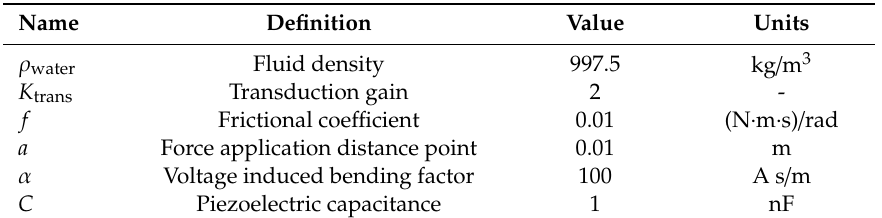
Table 1. Model parameters.